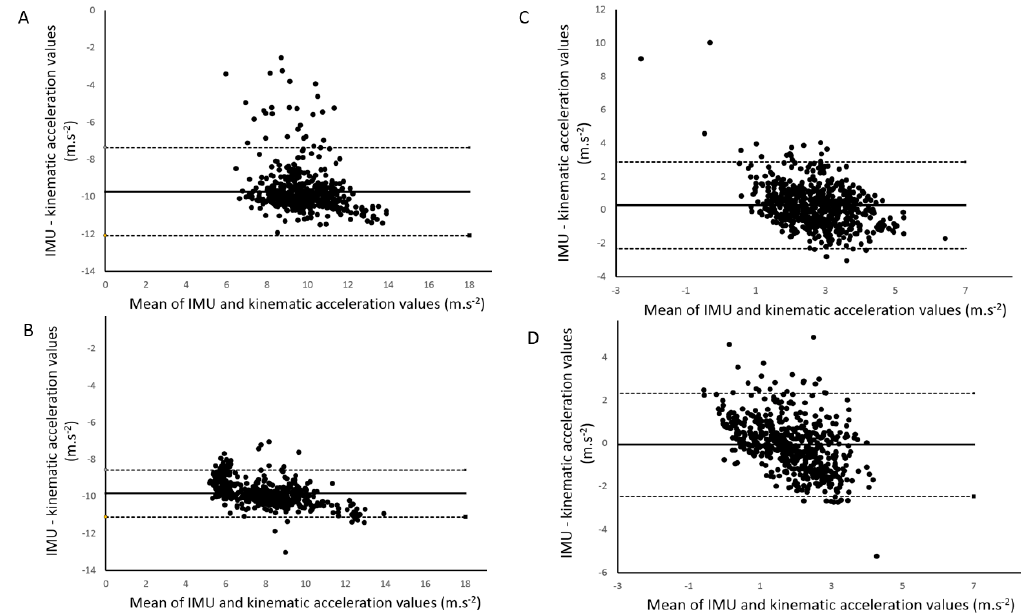
Figure 4. Bland–Altman plots for the acceleration values recorded without the cervical collar for the vertical axis (panel A , comfort speed; panel B , slow speed) and for the anteroposterior axis (panel C , comfort speed; panel D , slow speed), showing the differences between the two systems (i.e., inertial measurement unit (IMU) embedded in the glasses and kinematic analysis of the OptiTrack) against the mean of the two systems. The solid horizontal lines represent the estimated bias and the dashed lines represent the 95% limits of agreement.